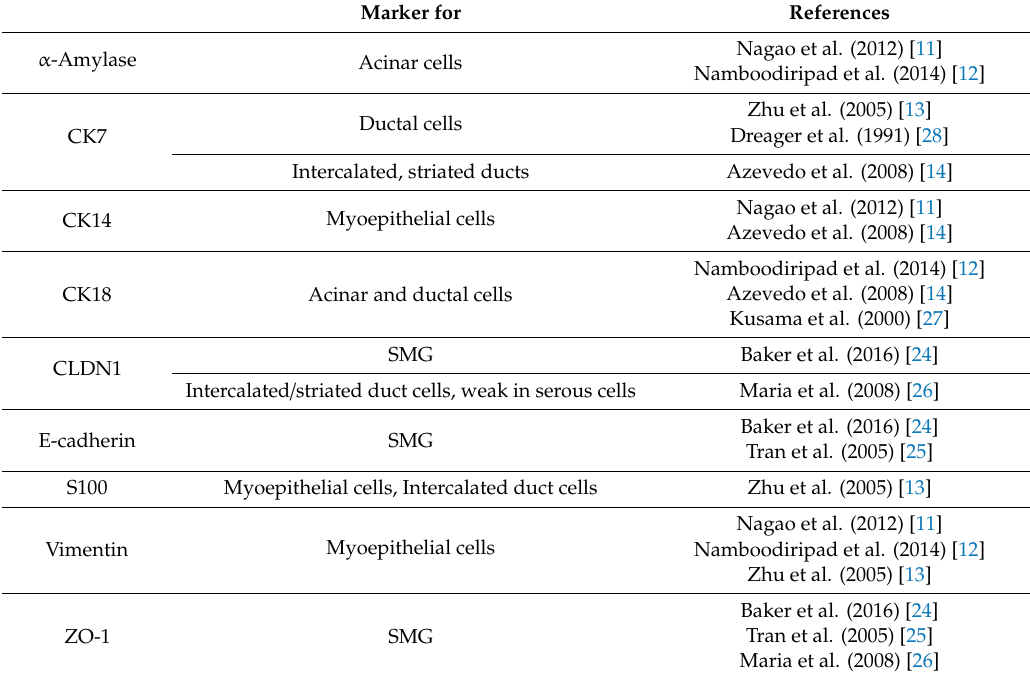
Table 1. Overview of the markers used for characterization of the salivary gland cell types. Marker